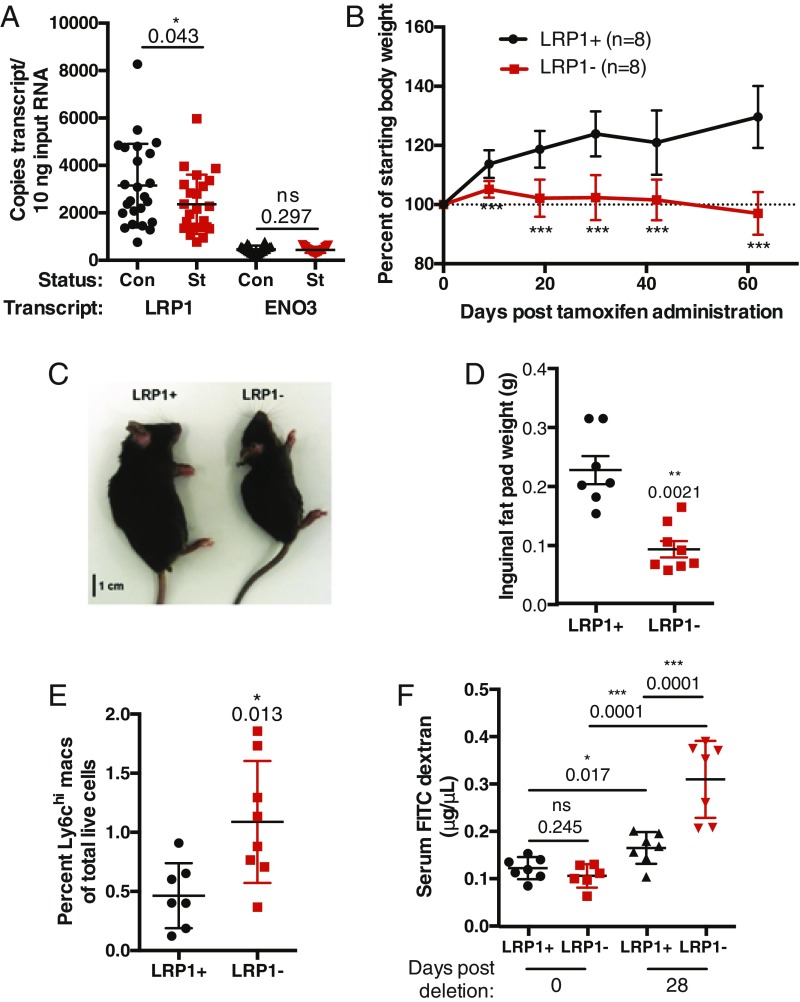
LRP1-deleted mice have a stunted phenotype and recapitulate pathophysiological aspects of stunting in humans. (A) LRP1 RNA levels in whole blood from 1-y-old control (Con) or stunted (St) children. ENO3 was chosen as an unaffected control. (B) Percentage weight gain in LRP-1fl/flCre-ERt2+ (LRP1−) and LRP-1+/+Cre-ERt2+ (LRP1+) mice after injection of tamoxifen. ***P < 0.001. (C) Appearance of LRP1+ and LRP1− littermates 40 d postinjection of tamoxifen. (D) Inguinal fat pad weight in LRP+ and LRP− mice. Each dot represents one animal. (E) Levels of Ly6Chi inflammatory macrophages in intestinal lamina propria from LRP1+ and LRP1− mice. (F) Serum FITC dextran levels in LRP1+ and LRP1− mice at 0 and 28 d posttamoxifen treatment.